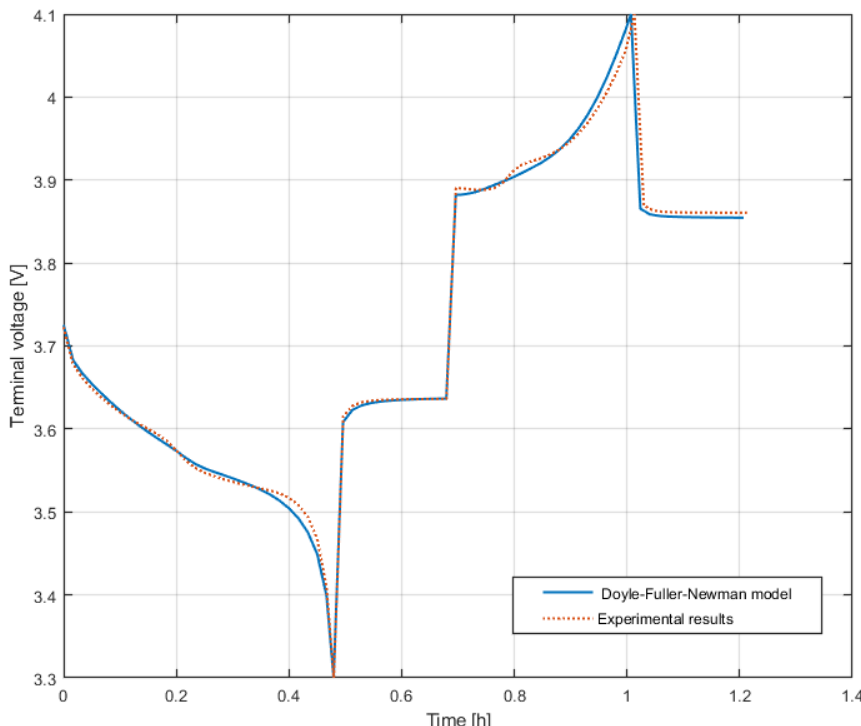
Figure 6. Comparison of charging/discharging cycle curves in the experiment and the DFN model of the